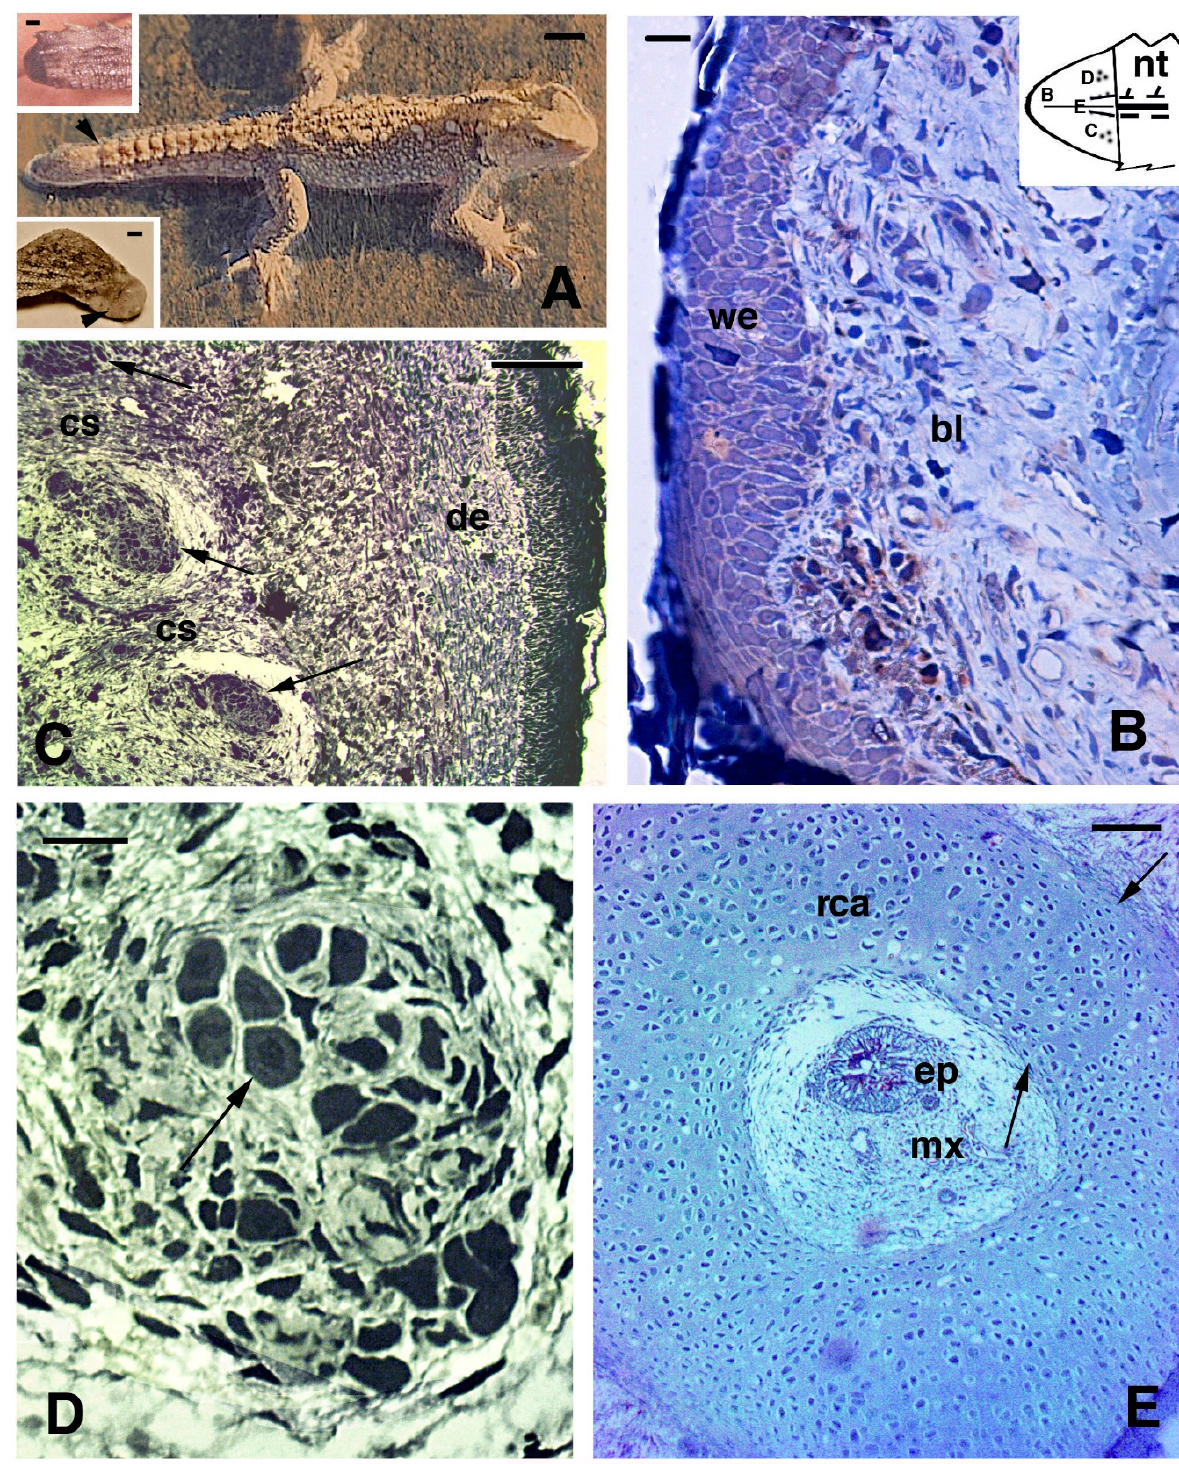
Figure 4. Gross aspect ( A ) and histology of regenerating tail (( B – E ), Toluidine blue stain). ( A ), juvenile of about 4 years of age with regenerated tail (arrowhead). Bar, 1 cm. In the upper inset (Bar, 1 mm) a blastema of about 2 months is shown. The scar (arrowhead) depicted in (A) lower inset formed after about 3 months following limb amputation. ( B ), blastema at about 3 months with a loose connective covered by a thick wound epidermis. Bar, 10µm. This schematic inset shows a blastema with the regions shown in ( B – E ). ( C ), proximal area of cross-sectioned conical blastema of 10 months post-autotomy showing three pro-muscle aggregates (arrows) separated by forming connective septa. A dense dermis is present beneath the cornified epidermis. Bar, 50µm. ( D ), detail of a muscle bundle at 10 months post-autotomy. The arrow indicates a myotube in cross-section. Bar, 10µm. ( E ), cross sectioned central cartilaginous cylinder surrounding the